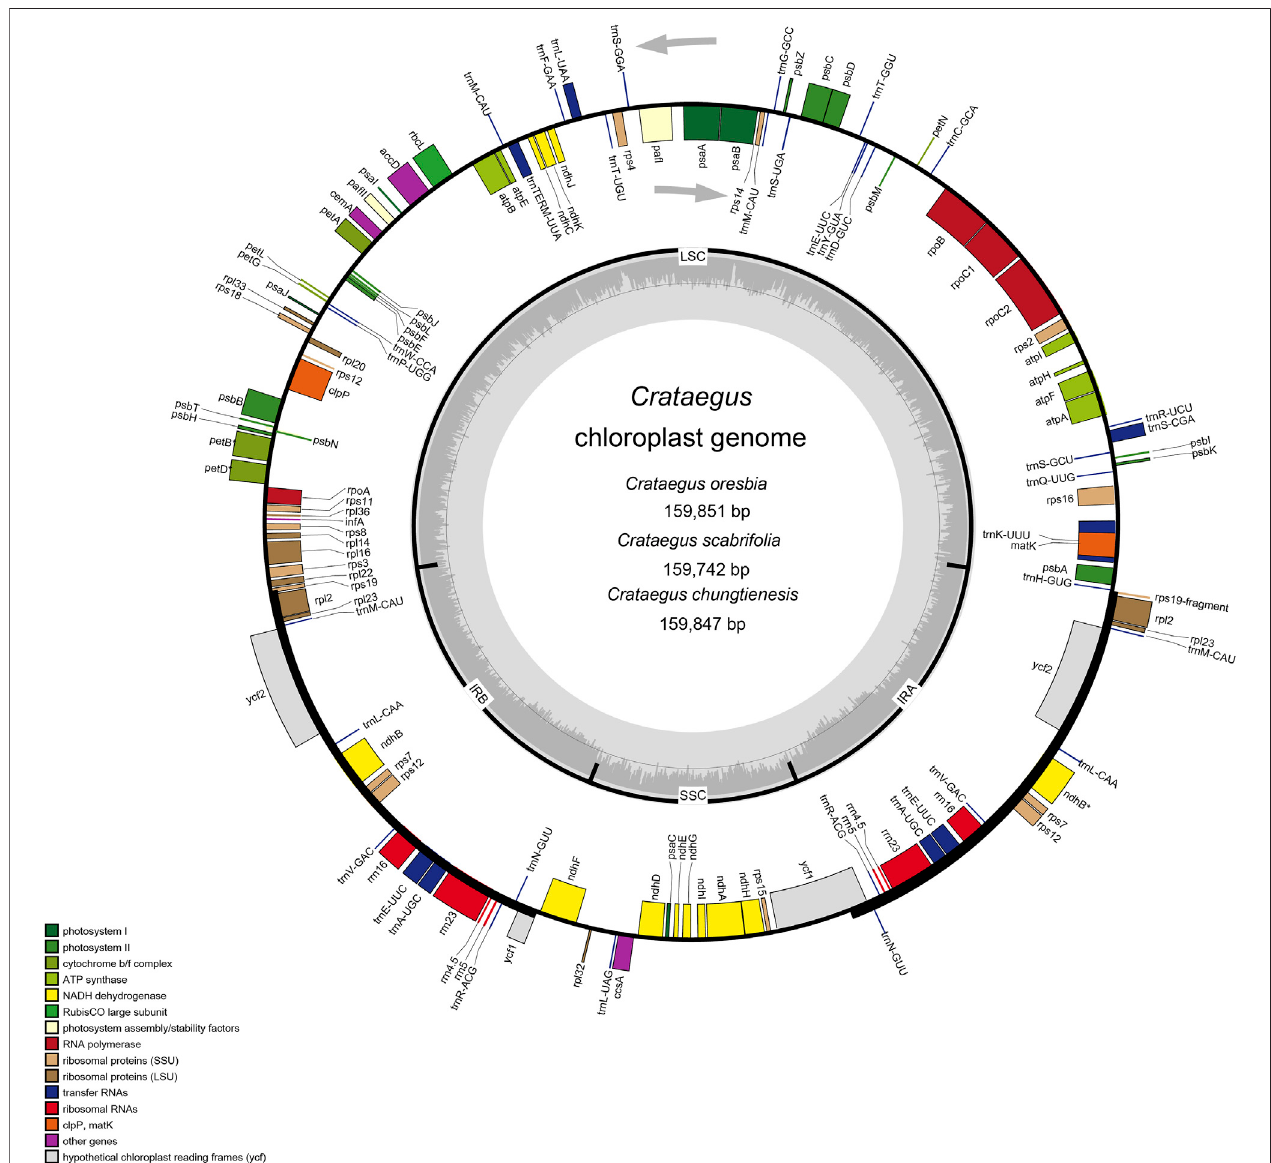
FIGURE 1 | Chloroplast genome maps of Crataegus ( C. oresbia , C. scabrifolia , C. chungtienesis ). In the diagram, different colors indicate genes with different functions. The genes inside circles are transcribed clockwise and genes outside circles are transcribed counterclockwise. Two inverted repeats (IRa and IRb), a large single copy region (LSC) and small single copy region (SSC) regions are shown in the inner circles. The light gray inner circles indicate A/T content and the dark gray circles indicate G/C content.